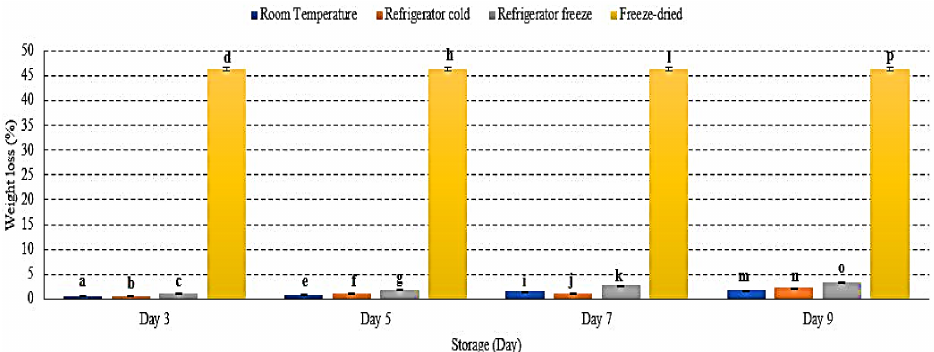
Figure 1. The weight loss of watermelon at different storage temperatures during 9 days of storage. Different letters of a, b, c, d, etc. indicate significant differences between samples p < 0.01.